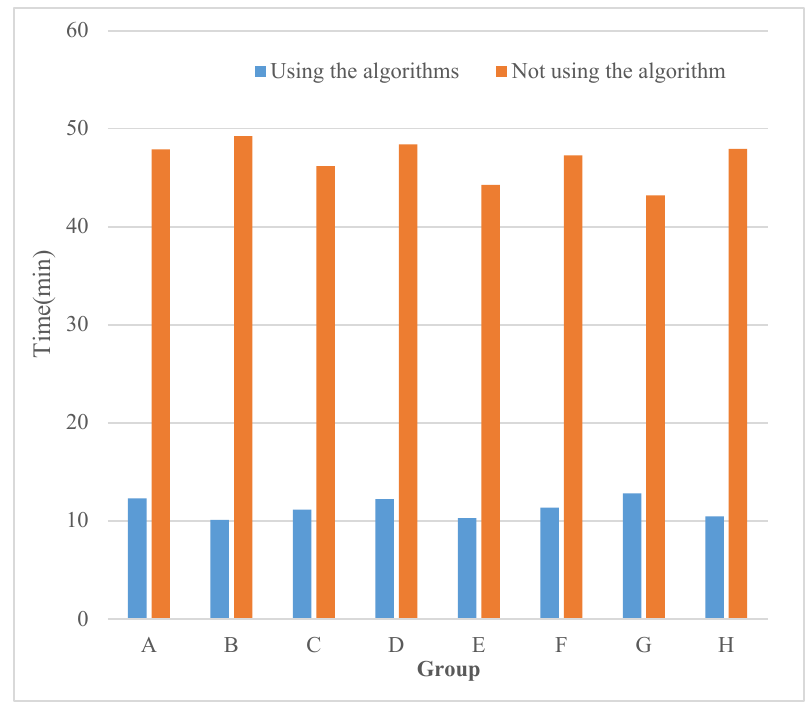
Figure 6. Rate experiment comparison results.